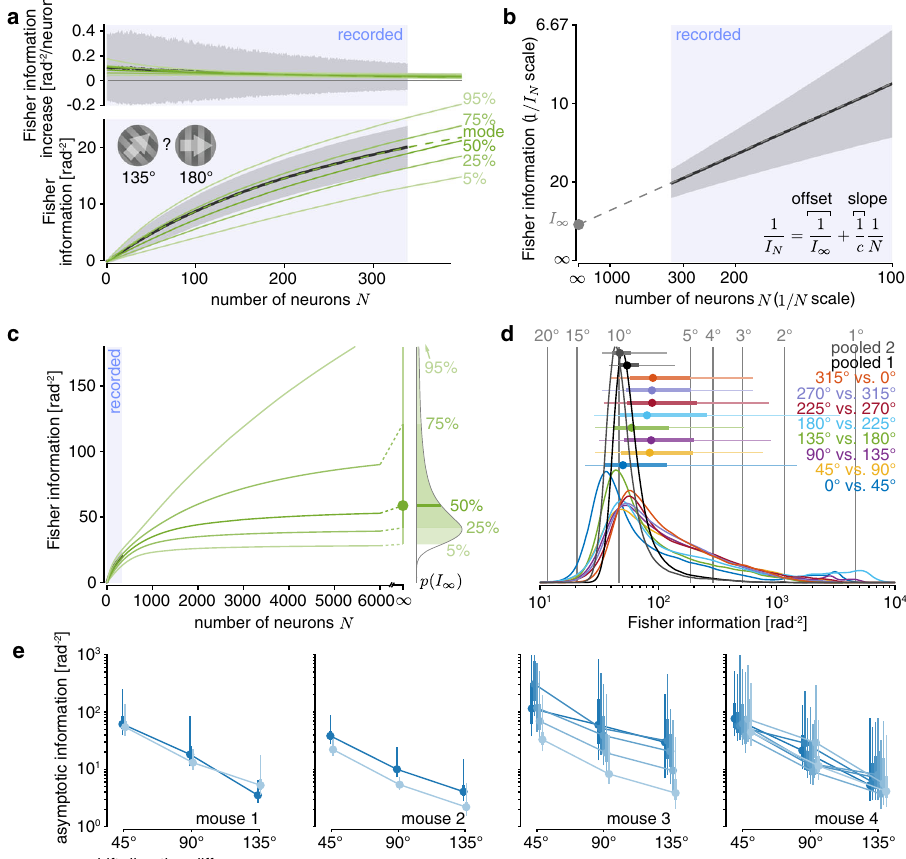
Fig. 4 Information about drift direction is estimated to asymptote in large neural populations. a Example information scaling fi t, showing data (black; mean estimate ± 1 SD; computed from 135 ° vs. 180 ° drift direction trials, as in Fig. 3c) and posterior predictive density for Bayesian fi t (green; solid = percentiles, dashed = mode) for the Fisher information increase (top) and Fisher information (bottom) across different population sizes N . The model is fi tted to the Fisher information increase estimates (top), as these are statistically independent across different population sizes. b Plotting the inverse Fisher information 1/ I N over the inverse population size 1/ N (mean estimate ± 1 SD; same data as in a ) shows an almost perfect linear scaling, as predicted by our theory. Fitting a linear model (gray dashed line) reveals a non-zero asymptotic information I ∞ (gray dot) with N → ∞ c . The fi tted model supports extrapolating the posterior predictive density beyond recorded population sizes (blue shaded area in a – c ) up to N → ∞ . This results in a Bayesian posterior estimate over the asymptotic information I ∞ (right), which we summarize by its median (dot), and its 50% (thick line) and 90% (thin line; truncated at top) credible intervals. d Estimates of asymptotic information resulting from different drift direction pairs (colors; δθ = 45 ° for all pairs) results in comparable posterior densities (colored lines; associated density summaries above densities as in c ) across different pairs. Therefore, we pooled the data across all non-overlapping pairs with the same δθ to achieve a more precise estimate. The pooled estimates were comparable across two different sets of non-overlapping pairs (gray). The vertical gray lines and numbers indicate the drift direction discrimination thresholds corresponding to different Fisher information estimates. e The asymptotic Fisher information estimate (density summaries as in c ; lines connect posterior medians) is comparable across sessions (different colors; horizontally shifted to ease comparison) and